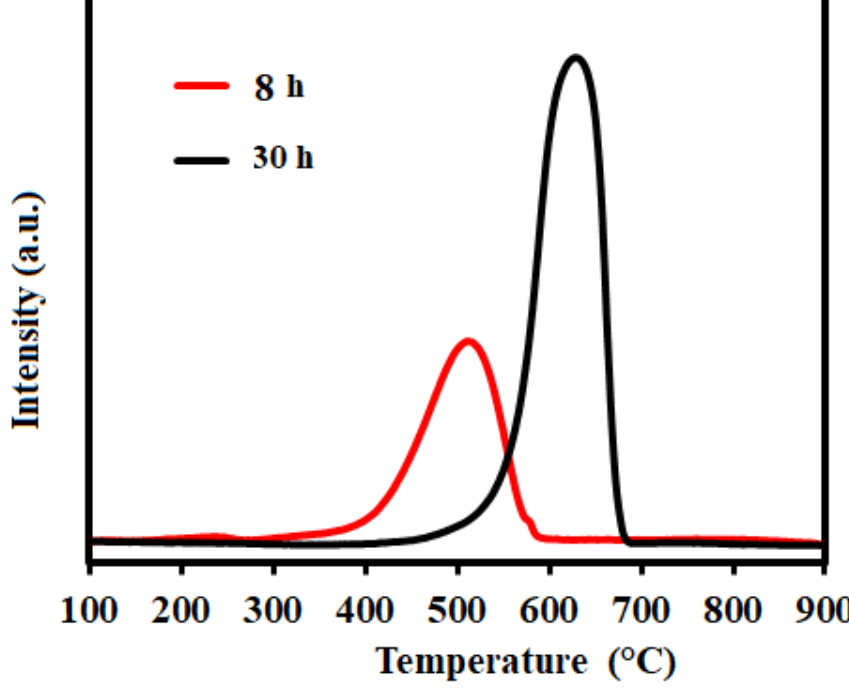
1 Figure 12. TPO of the used catalysts, calcined at 725 ° C for different reaction time in DRM at 700 °C; 1 bar.